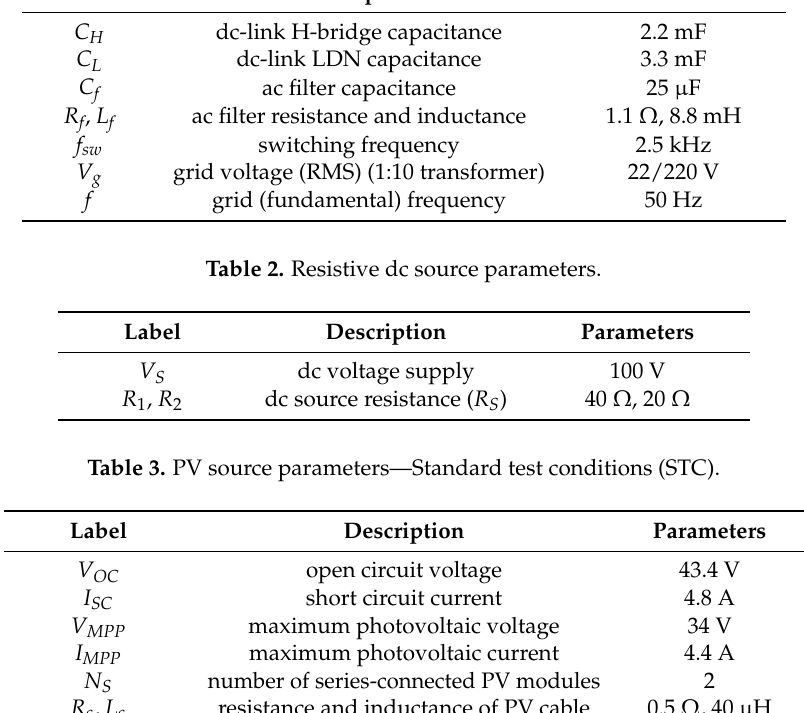
Table 1. Parameters of the conversion system.